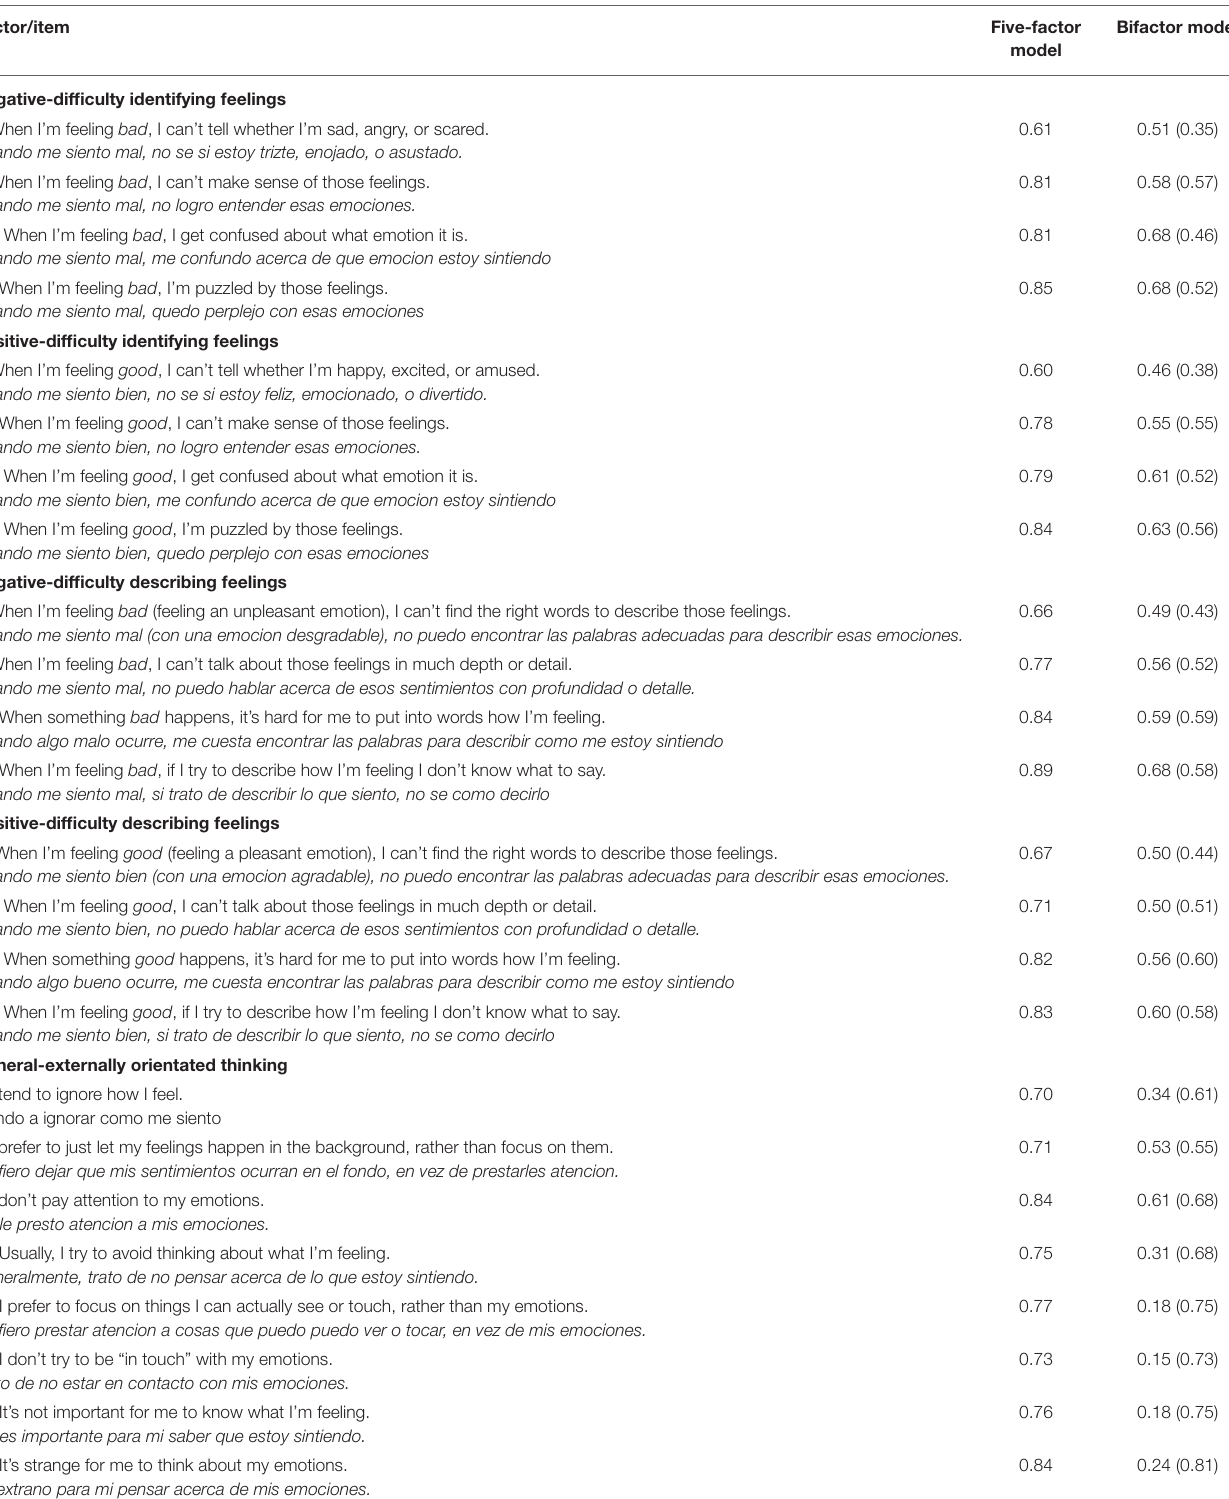
TABLE 2 | Standardized factor loadings from confirmatory factor analyses of the Perth alexithymia questionnaire (five-factor model and bifactor model).